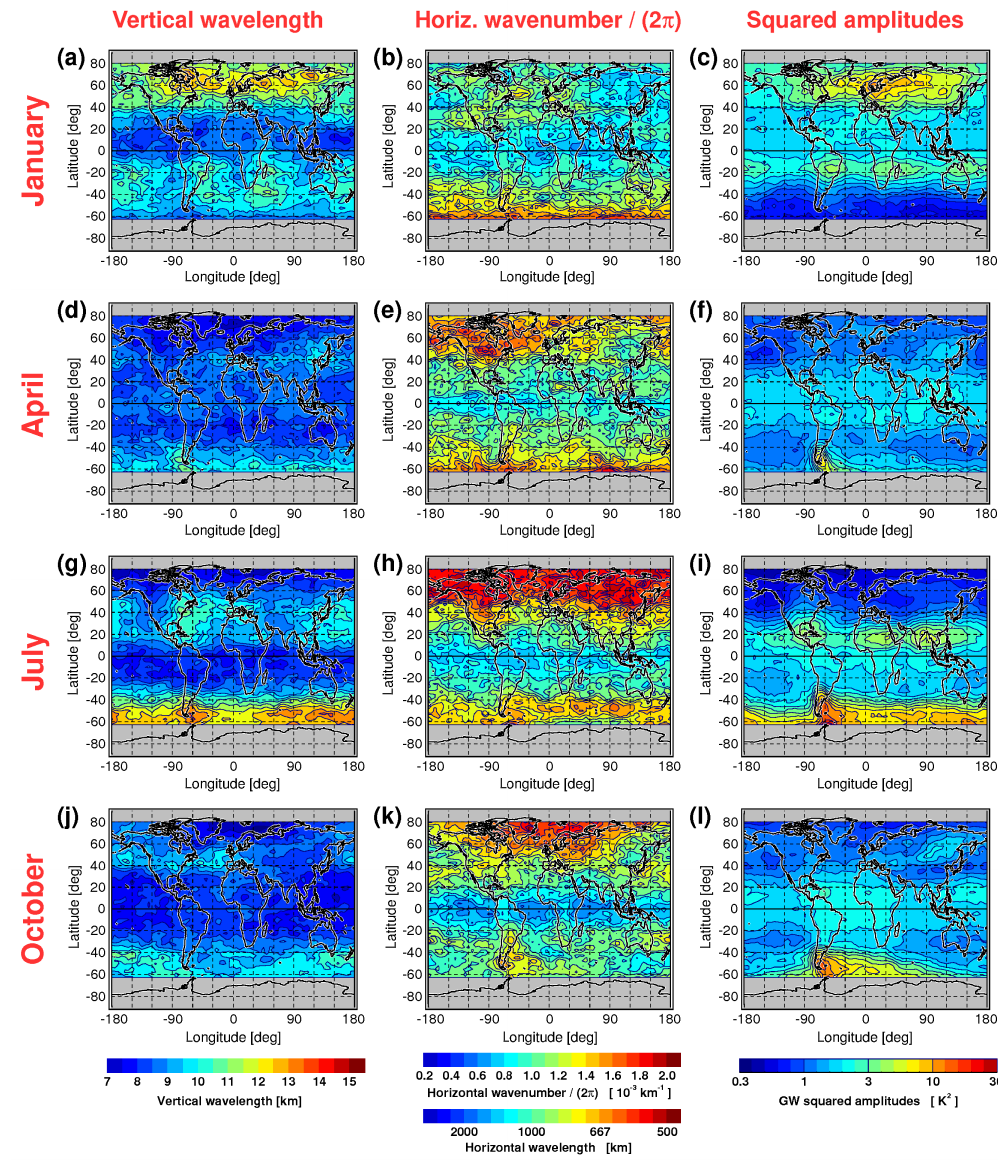
Figure 17. Global distributions of HIRDLS 3-year average gravity wave vertical wavelengths (a,d,g,j) , horizontal wavenumbers k h / (2 π ) (b,e,h,k) , and squared amplitudes (c,f,i,l) for different calendar months at 30km altitude.